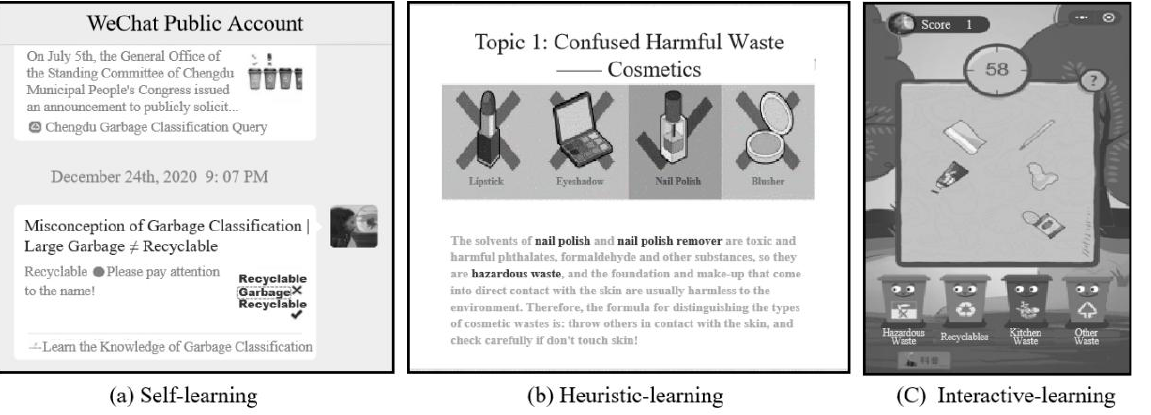
Figure 1. Instruction materials for different intervention groups. ( a ) Self-learning, ( b ) Heuristic- learning, ( c ) Interactive-learning.